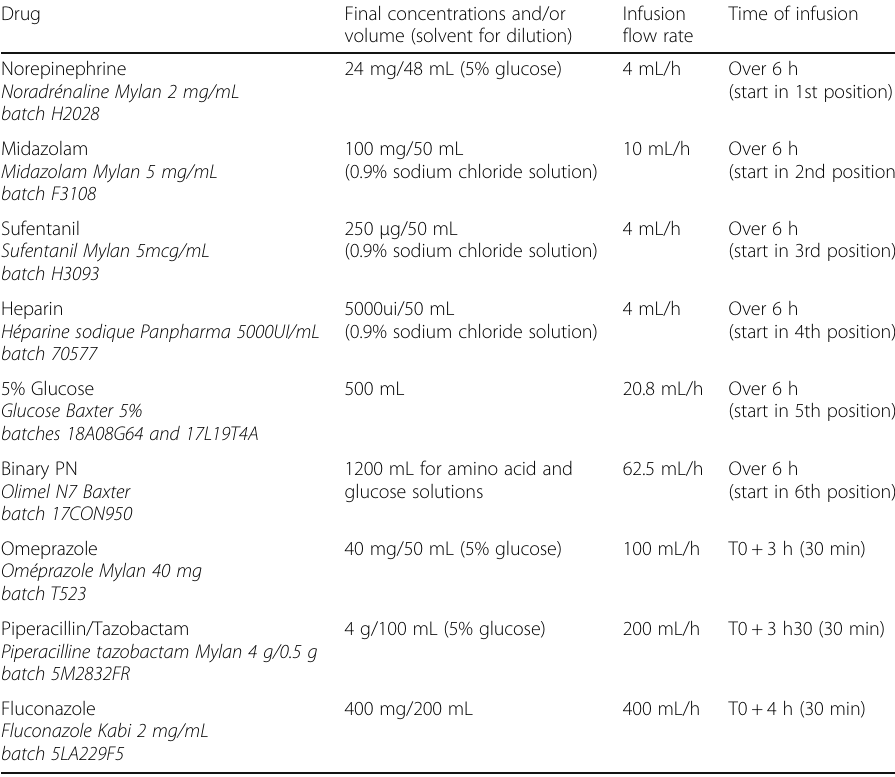
Table 1 Drugs Studied Drug Final concentrations and/or